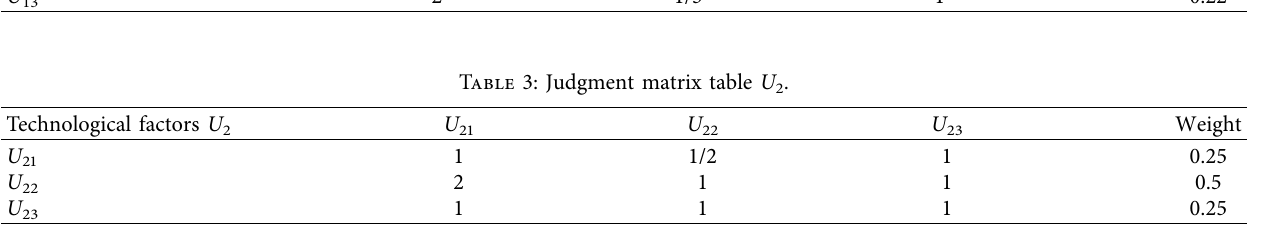
Table 4: Judgment matrix table U